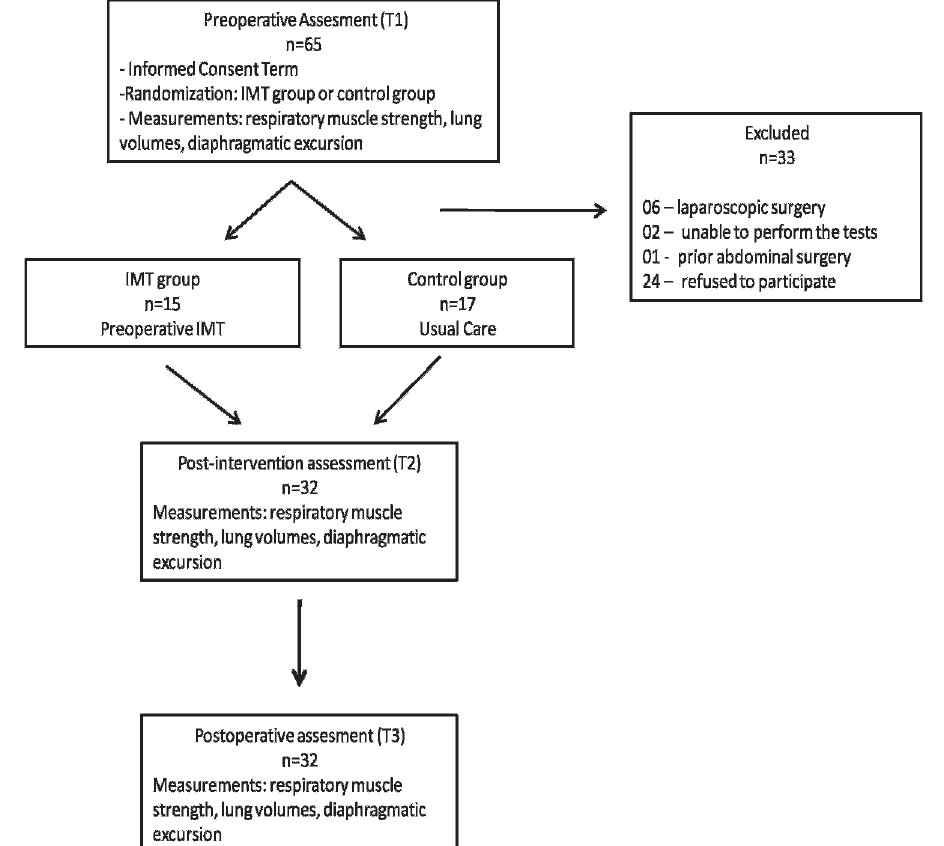
Figure 1 - Flowchart of the study participants.